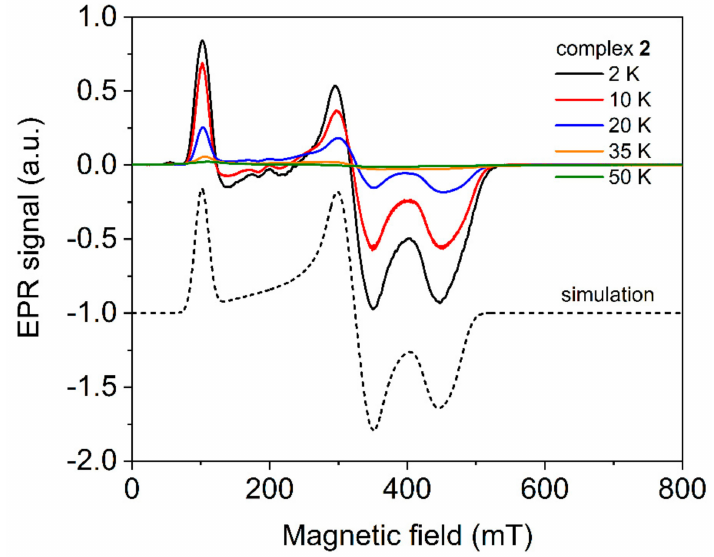
Figure 5. Temperature evolution of the EPR spectra of 2 measured with the excitation frequency of 9.4 GHz (solid lines). The simulation using the e ff ective spin S e ff = 1 / 2 model (black dashed line) with the parameters described in the text is